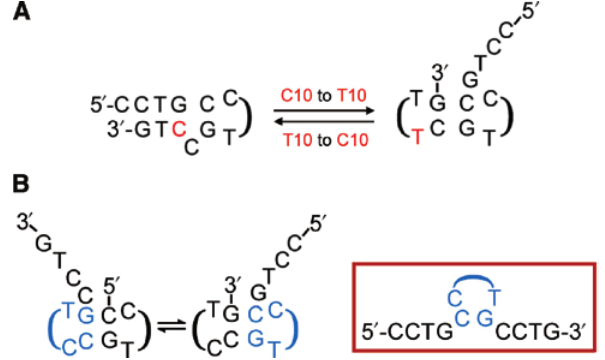
Figure 5: MDB can possibly be formed in a DNA sequence contain- ing three CCTG